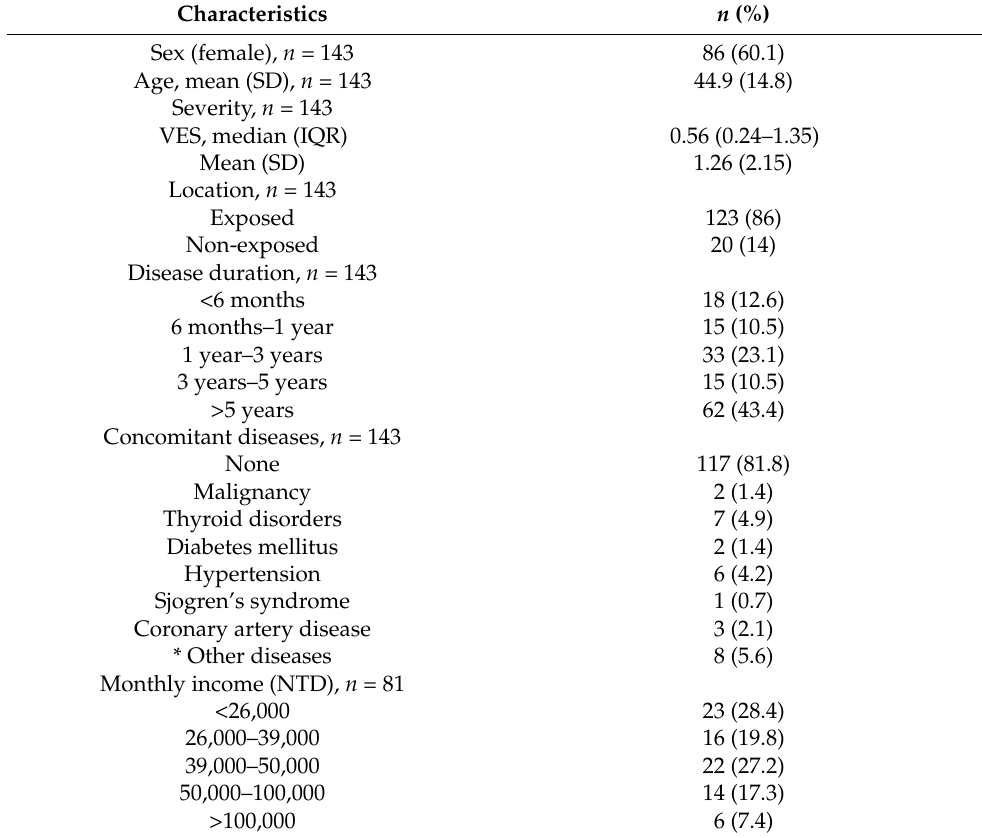
Table 1. Patient